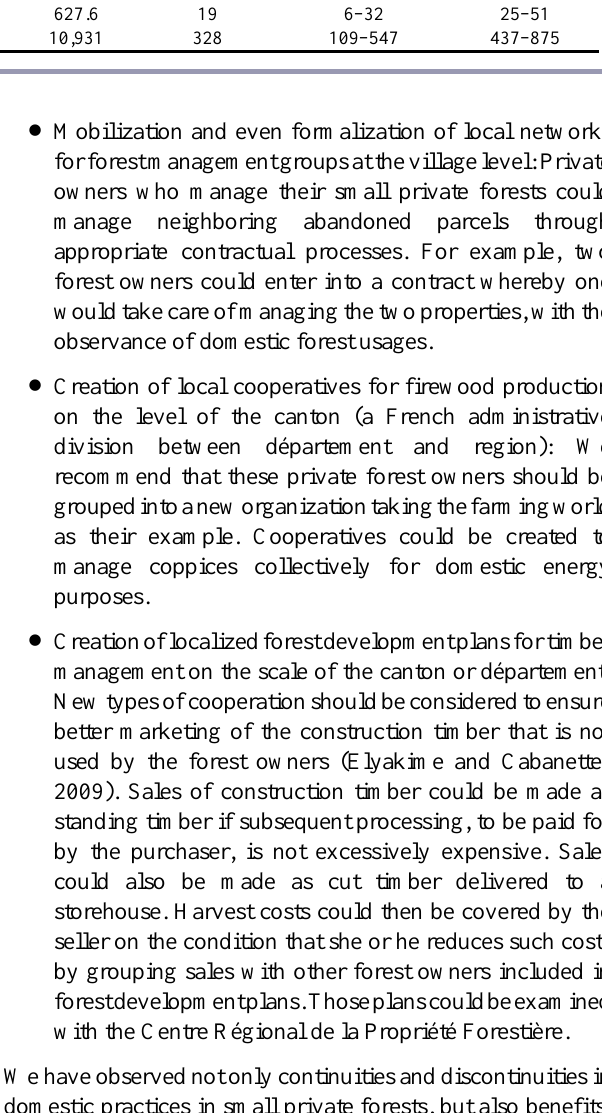
Table 1. Volumes, prices, values, funds, and annuities for 1 ha of a small woodlot in southwestern France. Type of wood Construction timber by age